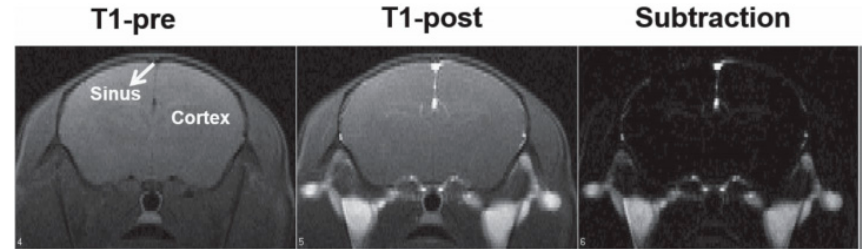
Figure 15. T 1 -weighted MR pictures of mouse brain, prior to (T 1 -pre) and post (T 1 -post) injection of the glutathione-functionalized iron-oxide nanoparticles. Reproduced from C.-L. Liu, Y.-K. Peng, S.-W. Chou, W.-H. Tseng, Y.-J. Tseng, H.-C. Chen, J.-K. Hsiao and P.-T. Chou; “One-Step, Room-